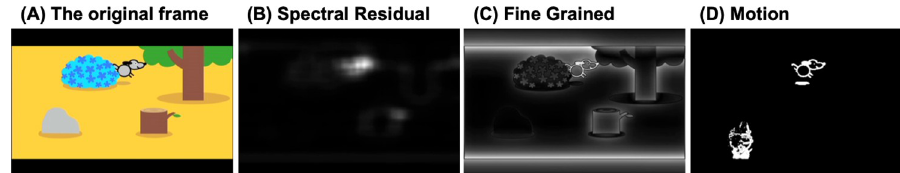
Fig 2. Original frame and the three types of saliency maps. (A) The original frame. (B) The Spectral Residual saliency map transformed from the original frame. (C) The Fine Grained saliency map transformed from the original frame. (D) The Motion saliency map transformed from the original